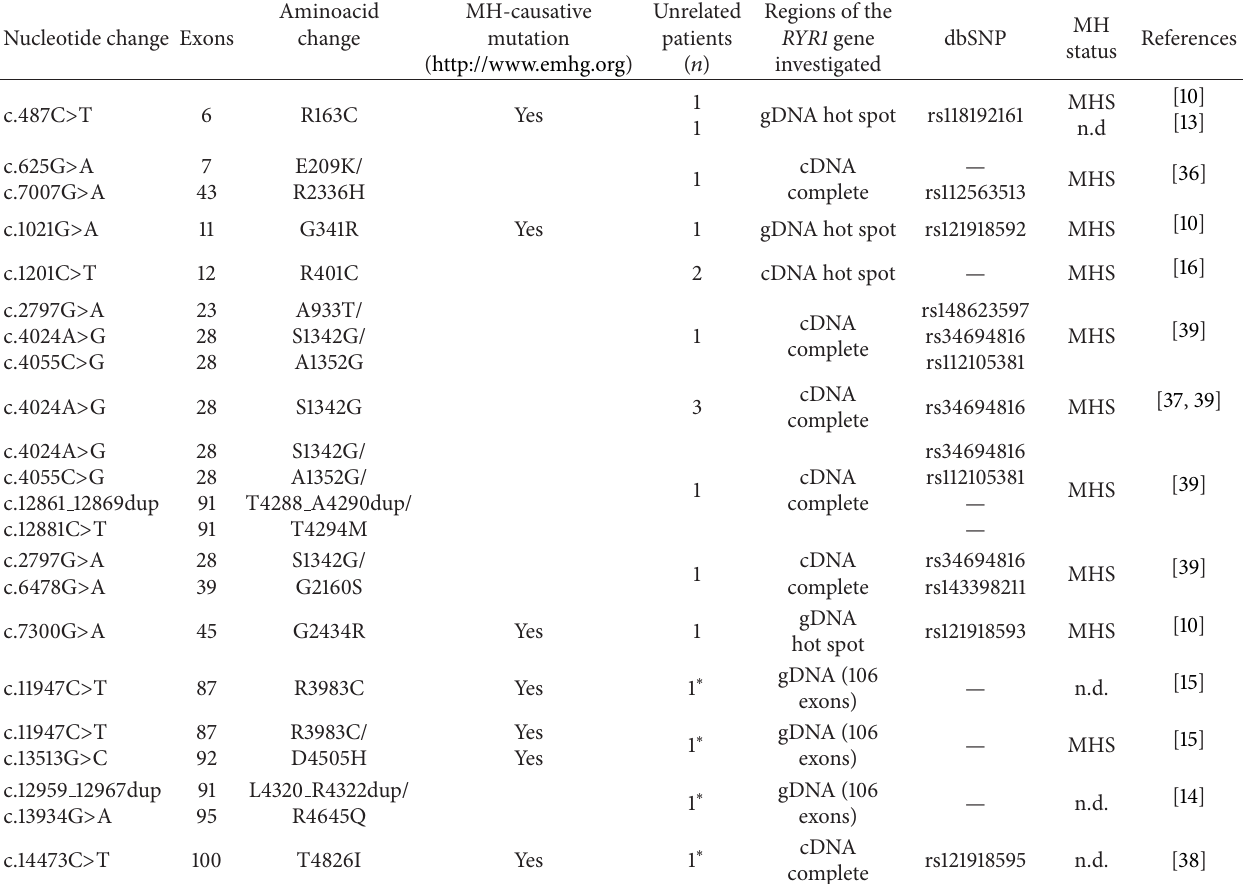
Table 1: RYR1 sequence variants reported in patients who experienced ER and stress-induced MH events.